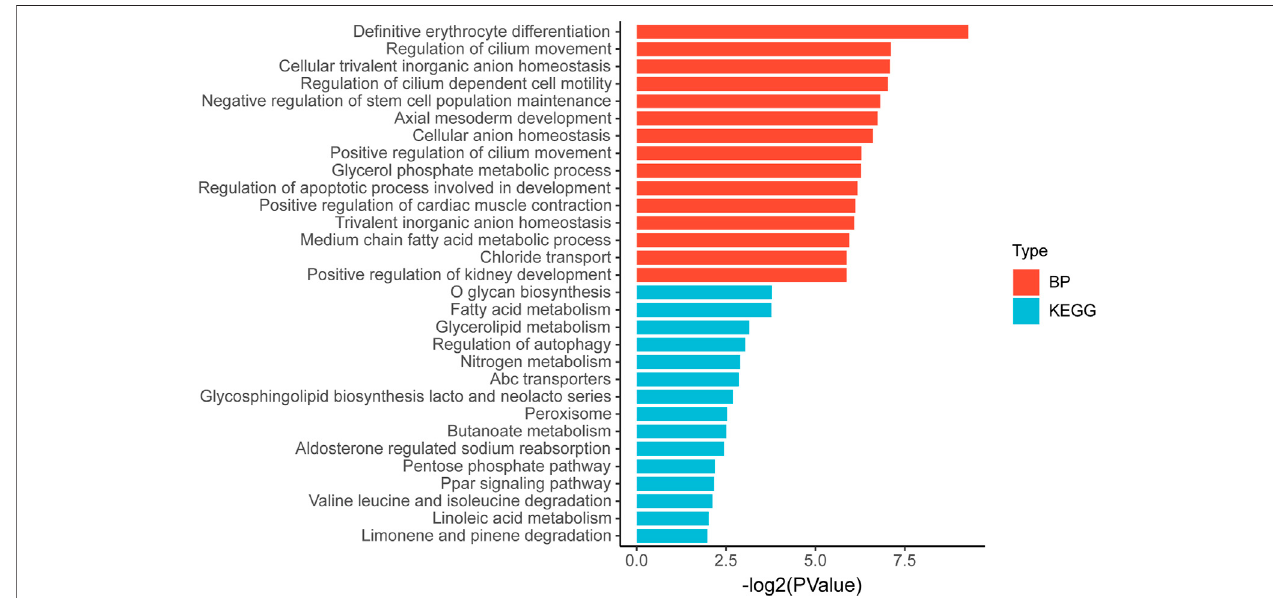
FIGURE 8 | Gene ontology and Kyoto Encyclopedia of Genes and Genomes pathway enrichment analysis of differential gene expression in high and low TP-PR groups.